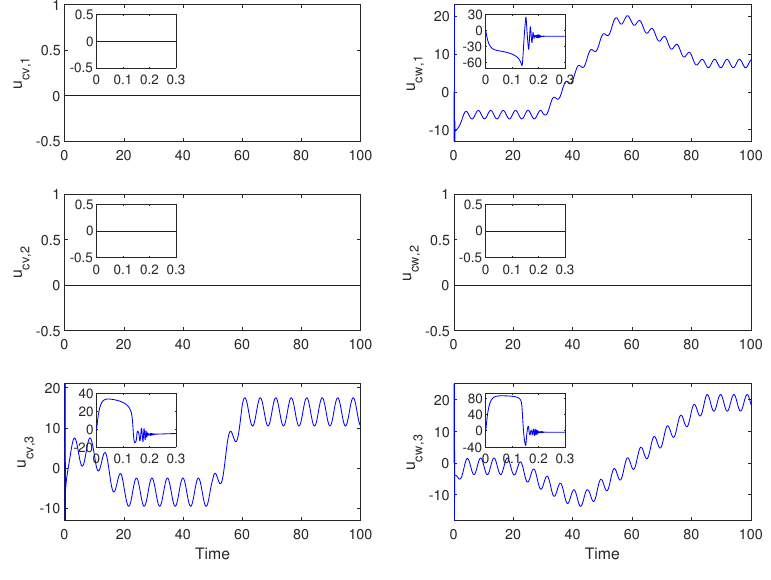
Figure 8. Compensating input u cc from the central